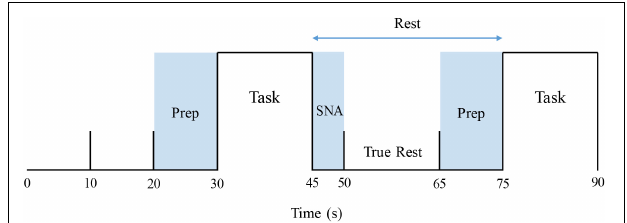
FIGURE 1 | Stimulus paradigm, covering the first 1.5 min of an apnea protocol. Prep: verbal instruction period. Task: Mueller maneuver or breath-hold (order for each participant allocated at random). SNA: “Spill-over” period during which elicited sympathetic excitation returned to baseline. True rest: the 15-s period between these two intervals that was used to determine pre-intervention resting baseline